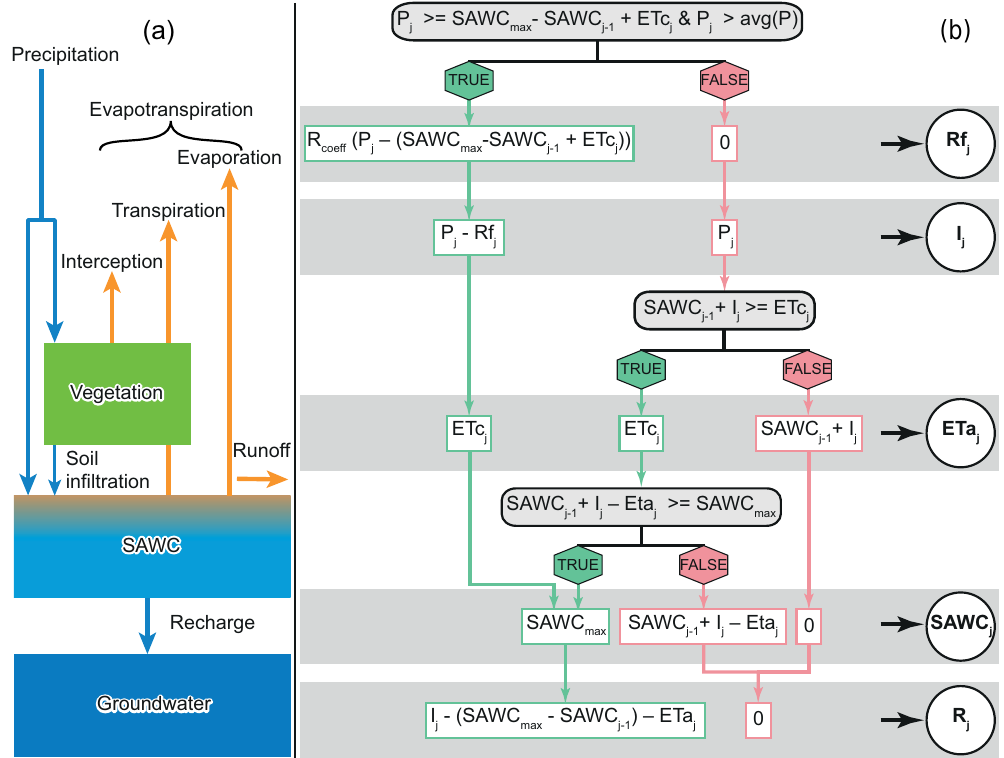
Figure 2. Soil-water balance: (a) soil-water balance conceptual representation and (b) soil-water balance diagram used for recharge com- putation on a daily frequency. SAWC: soil available water capacity; SAWC max : SAWC threshold (possible maximum); P : precipitation (rainfall + snowmelt); avg ( P ): precipitation average of the entire record; I : part of precipitation which infiltrates the soil; Rf: surface runoff; R coeff : runoff coefficient; ET c : specific vegetation evapotranspiration; ET a : actual vegetation evapotranspiration; R : recharge. Units: mil- limetres of water, except R coeff in percentage. Subscript j is the computation day and subscript j − 1 is the day before. TRUE and FALSE are the answers of the conditional inequality